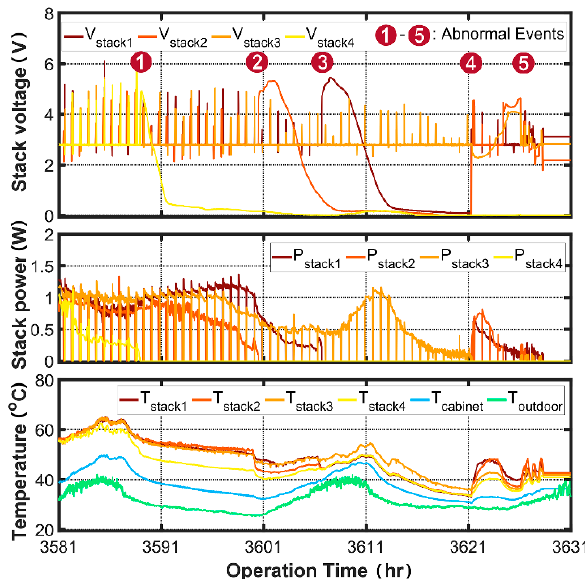
Figure 9. High-resolution experimental record from 3581 to 3631 h.